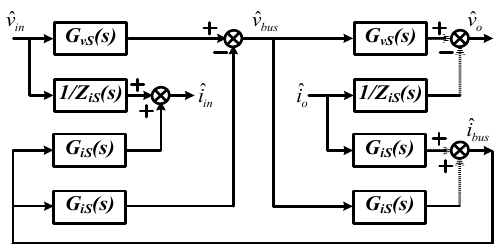
Figure 10. Dual-port network diagram of the series system.